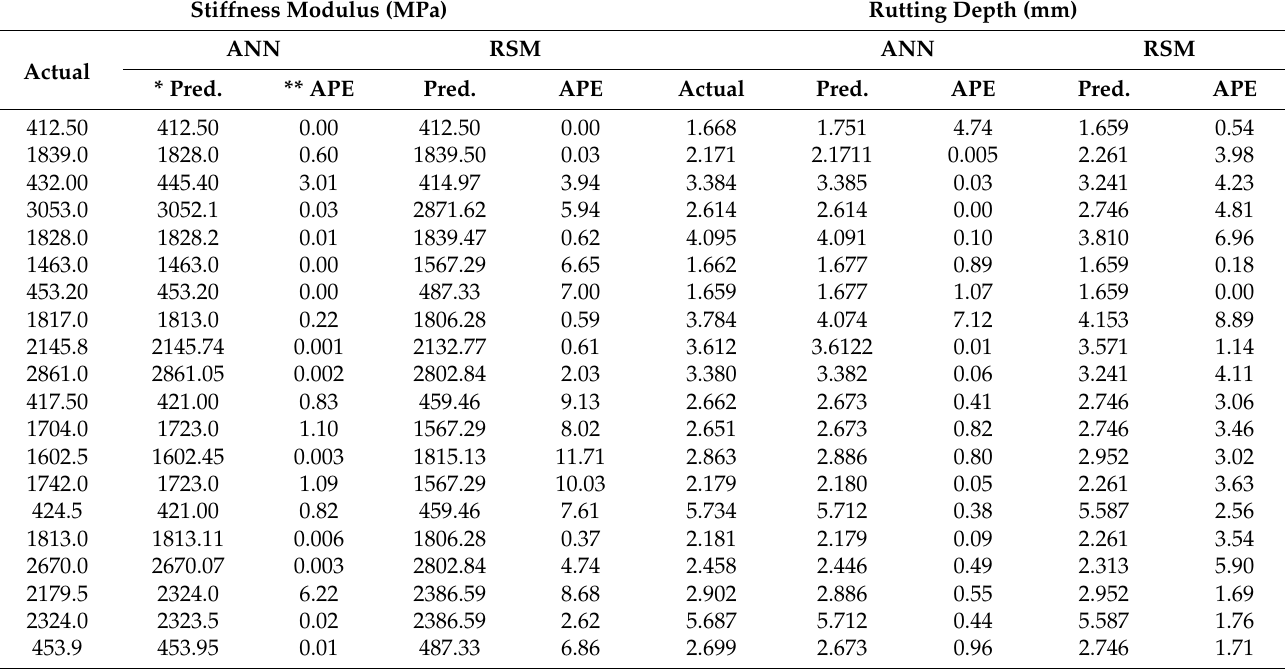
Table 10. Comparison between ANN and RSM prediction for the responses.